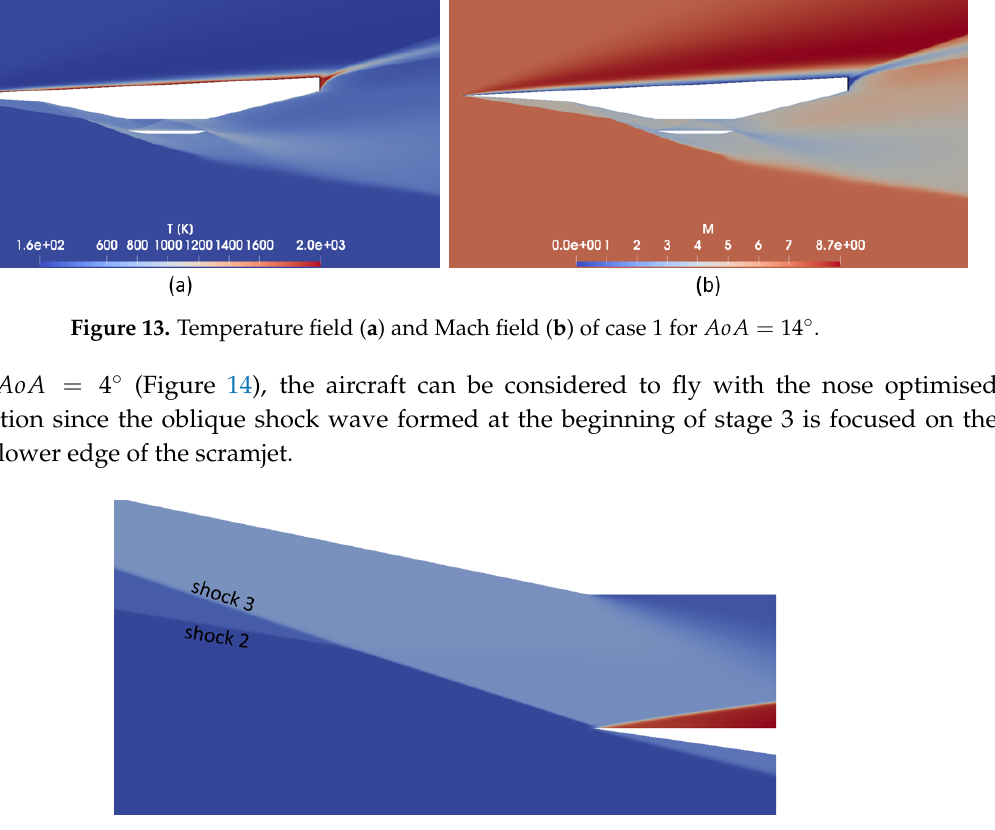
Figure 14. Tip of the lower edge of the scramjet of case 1 for AoA = 4 ◦